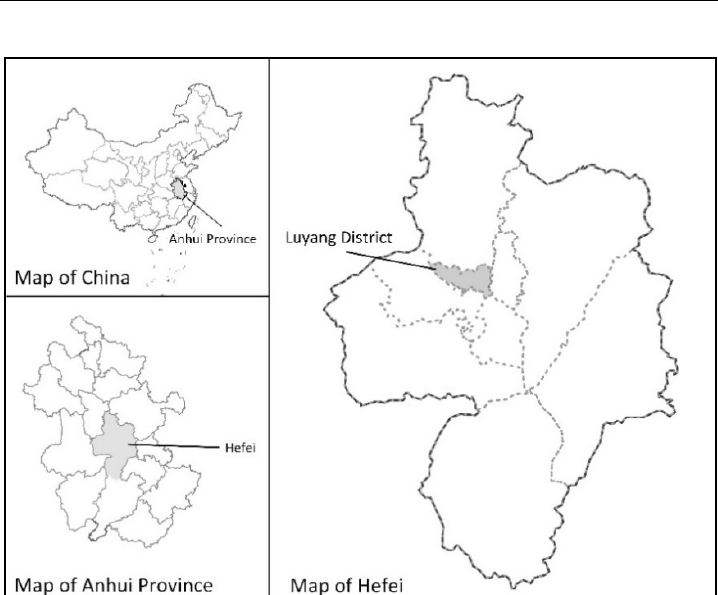
Figure 5. The distribution of eight selected communities on Xinglin Street. Our data collection process contained two phases. The first phase determined the URs and DRs of urban furniture design for pandemic prevention and control. During this phase, a user interview was conducted. During the user interview, a total of twenty ‐ two respond ‐ ents from diverse backgrounds were chosen to participate in our study, involving seven community workers, three community pharmacists, two PhD students in community de ‐ velopment, two industrial designers, three university teachers in design, three PhD students in design and two technicians. Their information is depicted as follows, see Table 2. Since some of the informants working in the communities were not far from us, we conducted a face ‐ to ‐ face interview. For the remaining informants, we conducted an online interview, mainly through two social media applications, namely QQ and We ‐ chat, due to the far distance. After that, we integrated the results of the user interview with a literature review to obtain the final DRs and URs of urban furniture design. The second phase is for pair ‐ wise comparisons of URs and DRs. During the second phase, a second user interview was conducted, as well as a questionnaire survey. Notably, the informants in the two user in ‐ terviews were the same. Regarding the questionnaire survey, 200 questionnaires were dis ‐ tributed to community workers, community managers, and local residents in these eight communities, including half of the online questionnaires and half of the paper question ‐ naires. Ultimately, we received 164 valid answers, which were used for data analysis. The demographic information and partial contents of the questionnaire survey respondents are demonstrated in Table 3. Table 2. Description of respondents in the user interview.